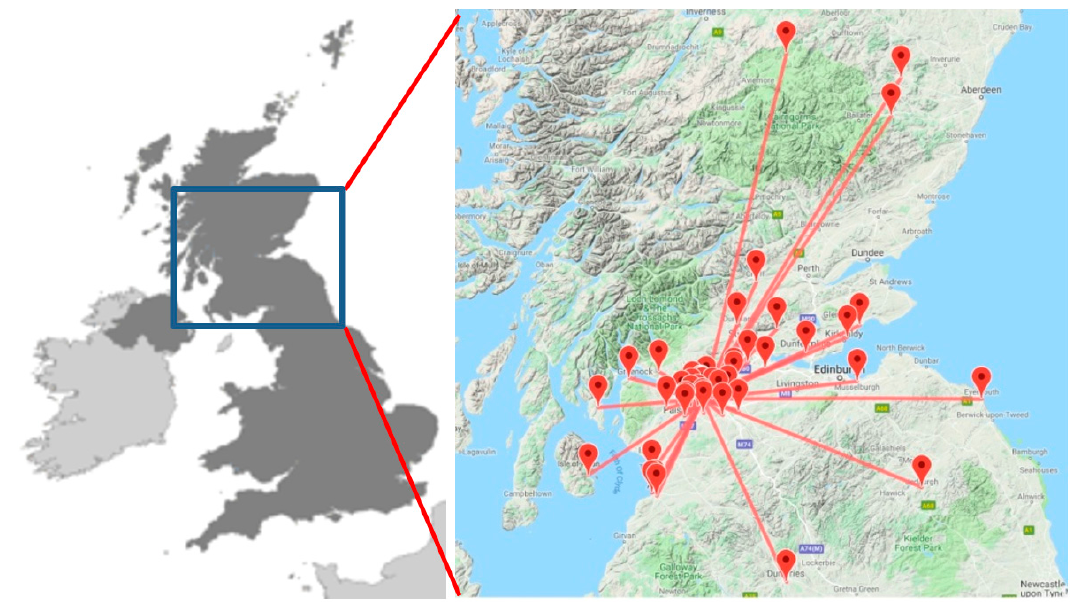
Figure 1. Map showing locations of schools submitting soil samples.